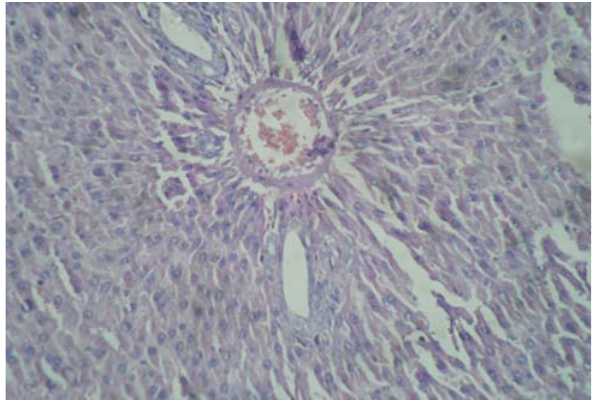
Fig 1. Photomicrograph showing architecture of liver of baseline control rats (×400)